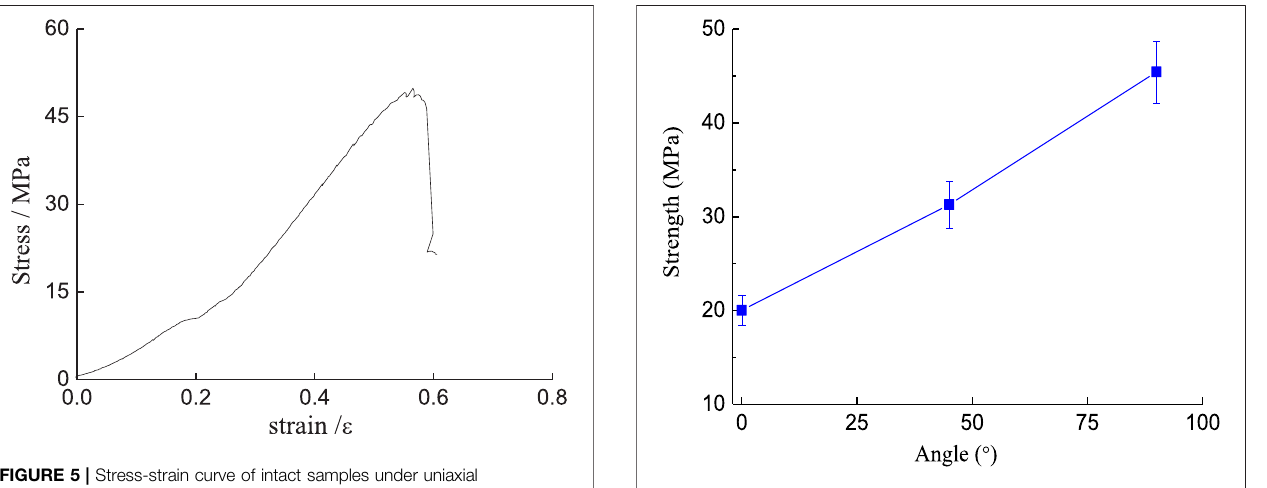
FIGURE 6 | Single fi ssure samples with different inclination angles.